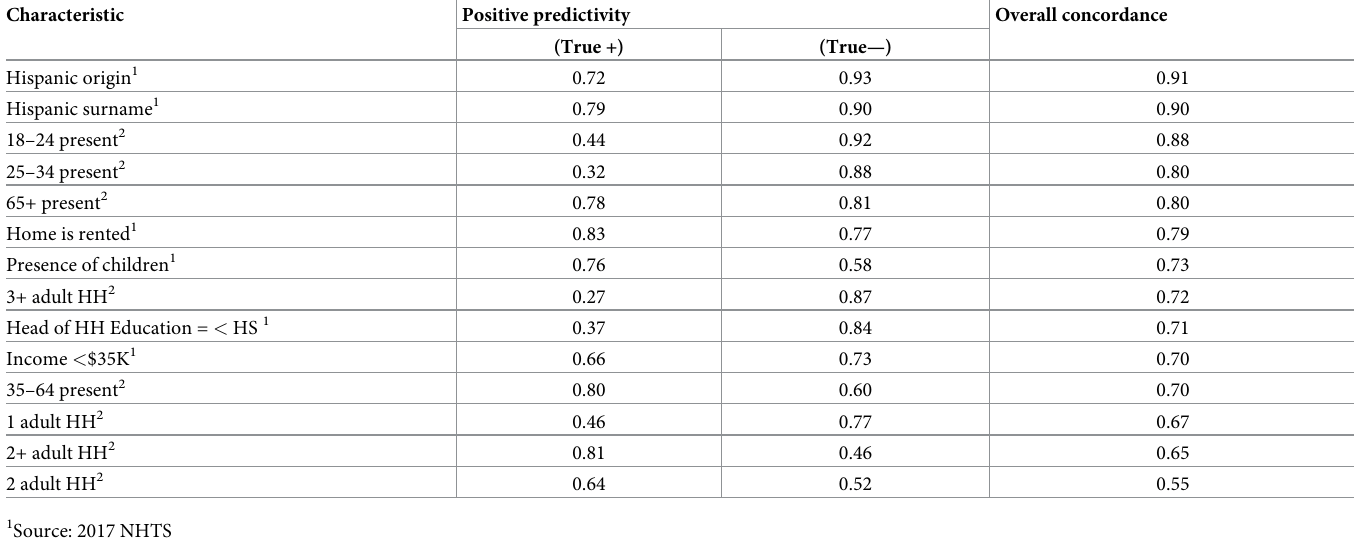
Table 2. Predictivity and concordance